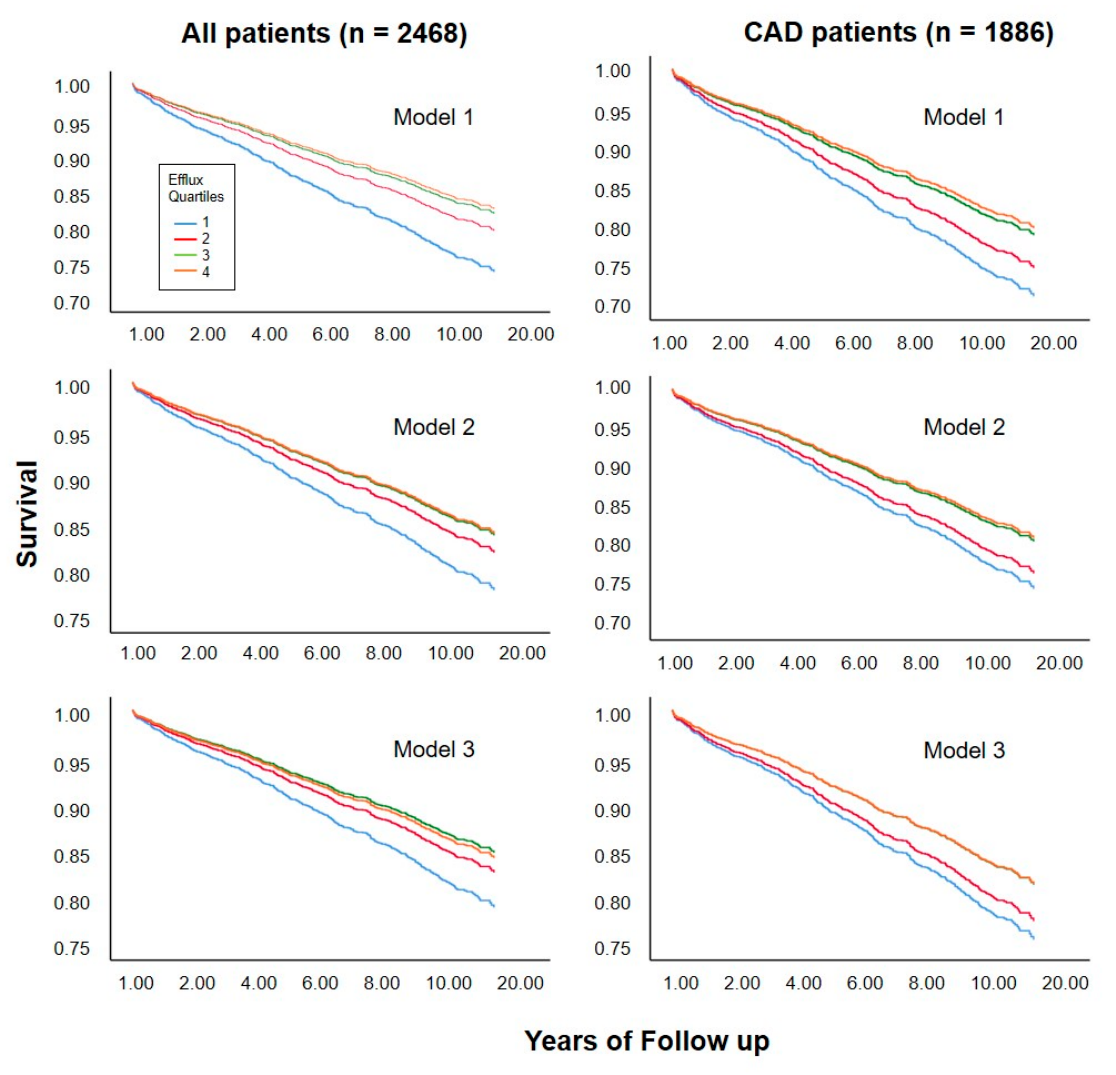
Figure 4. Survival curves according to quartile of cholesterol efflux capacity. Curves were estimated in proportional-hazards models without adjustment (model 1), adjusted for age and sex (model 2), or for age, sex, and traditional risk factors for cardiovascular disease including use of statins, CAD, diabetes mellitus, smoking, triglycerides, and LDL cholesterol (model 3).